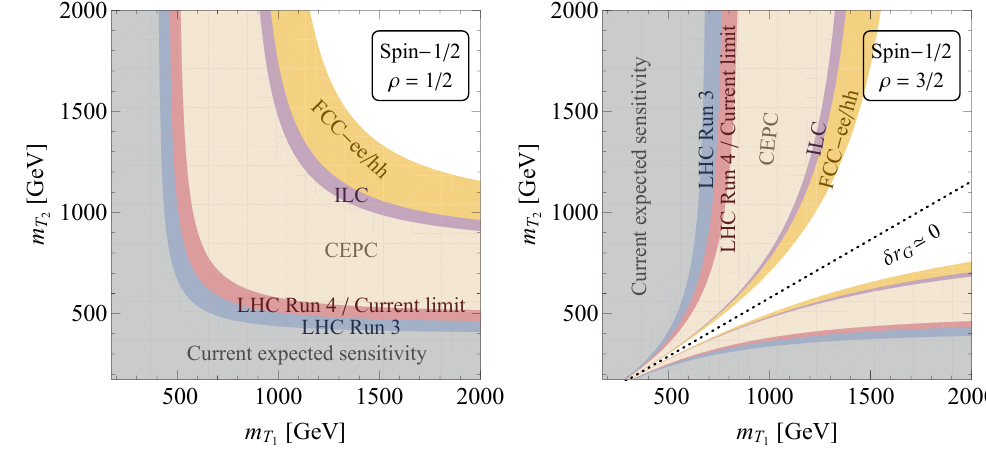
Figure 10 . Excluded parameter space and expected sensitivities at the 2 (cid:27) C.L. of current and future data (various colors) for two spin-1/2 top partners in the m T shows the case in which both spin-1/2 top partners contribute equally to canceling the Higgs-mass contribution of the top-quark loop, i.e. (cid:26) = 1 = 2, where (cid:26) is de(cid:12)ned in eq. (5.34). In the right plot, T 2 contributes with the same sign as the top-quark to the Higgs mass, but both contributions are cancelled by T 1 , (cid:26) = 3 = 2. The latter allows for a \stealth" limit (black dotted line), in which Higgs precision measurements are not sensitive to the presence of spin-1/2